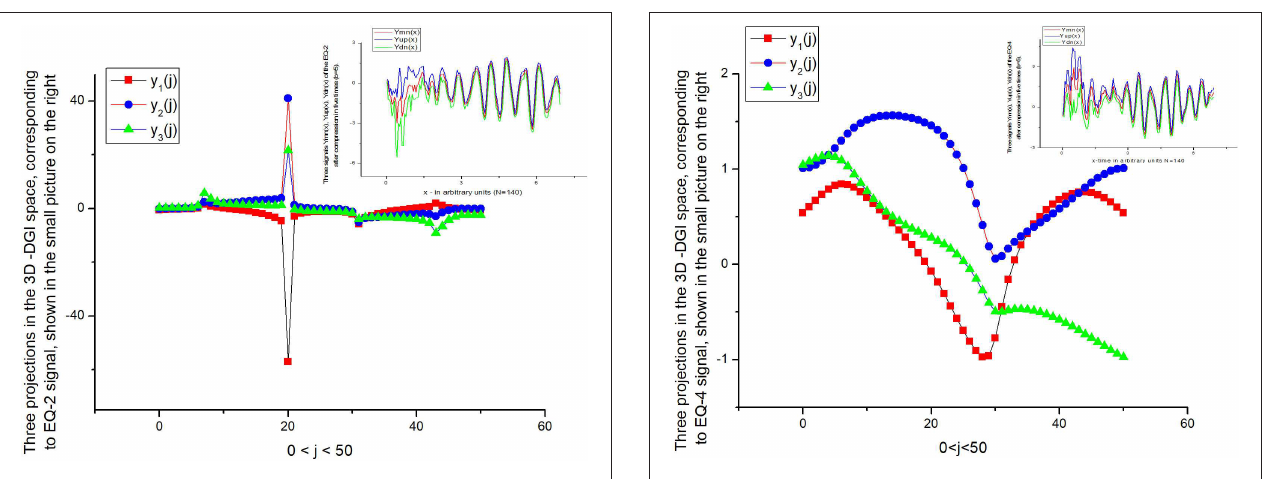
FIGURE 11 | Three curves corresponding to the projections of the EQ-2 signal. As one can notice this signal is different to the signal shown in Figure 9 . Therefore, the usage of the y 1,2,3 ( j ) projections helps to differentiate them, at least qualitatively.